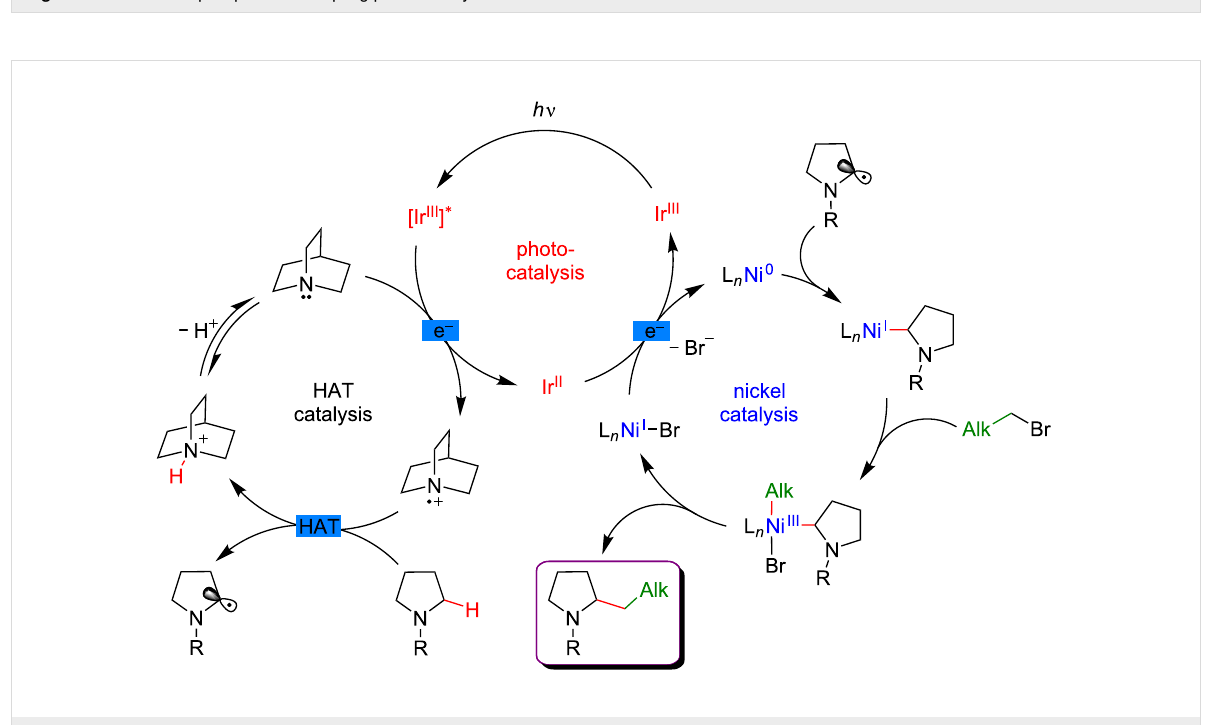
Figure 65: Proposed mechanism for the selective sp 3 –sp 3 cross-coupling promoted by